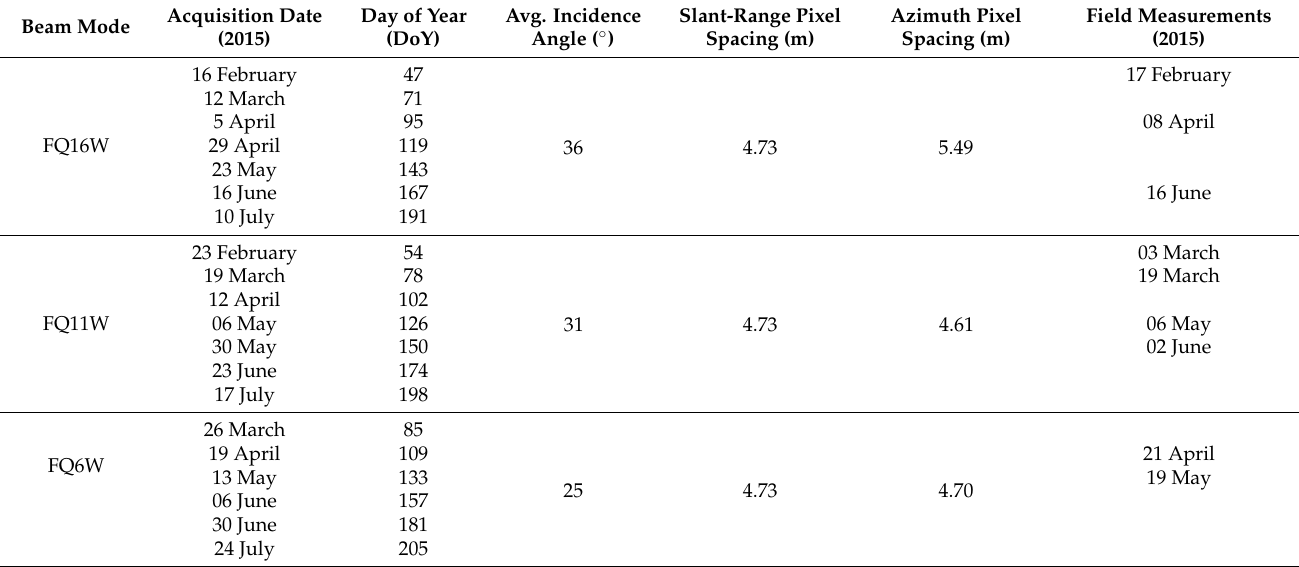
Table 1. List of RADARSAT-2 data grouped by beam mode and their correspondence with field